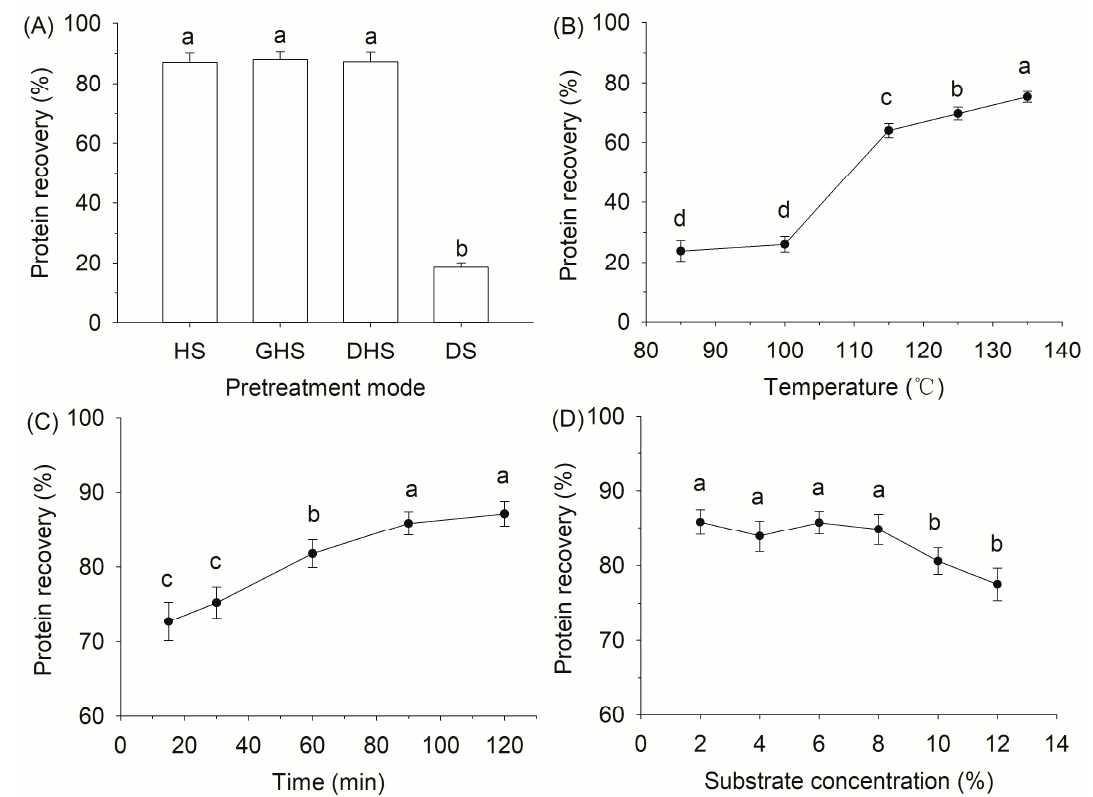
Figure 1. Effect of hydrothermal pretreatment on protein recovery of fish scales: (I) pretreatment mode ( A ), fish scales (HS), ground scales (GHS) and decalcified scales (DHS) after hydrothermal pretreatment (135 °C for 90 min) and decalcified scales (DS); (II) effect of temperature ( B ), time ( C ) and substrate concentration ( D ) on protein recovery of fish scales during the hydrothermal treatment. Different letters indicate that the results differ signi fi cantly ( p < 0.05).